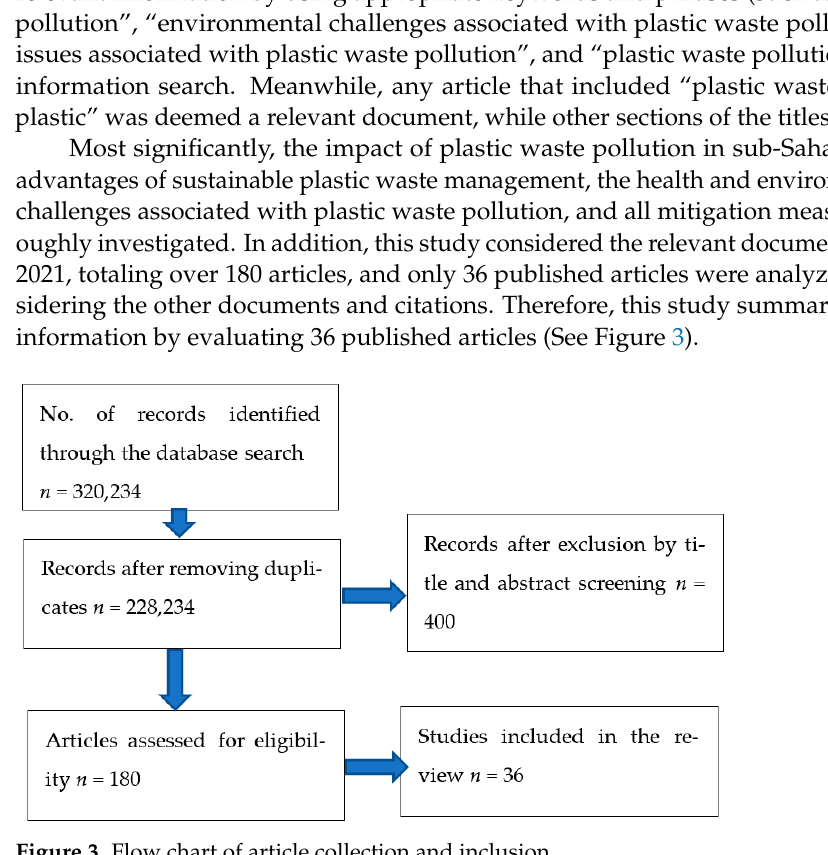
Figure 3. Flow chart of article collection and inclusion.